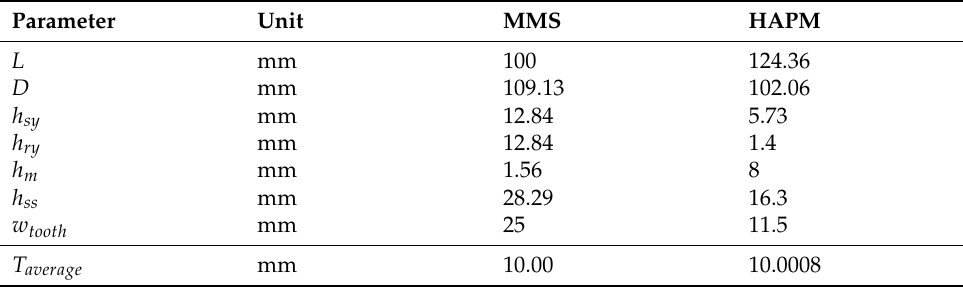
Table 6. Inputs to the Femm code for MMS and